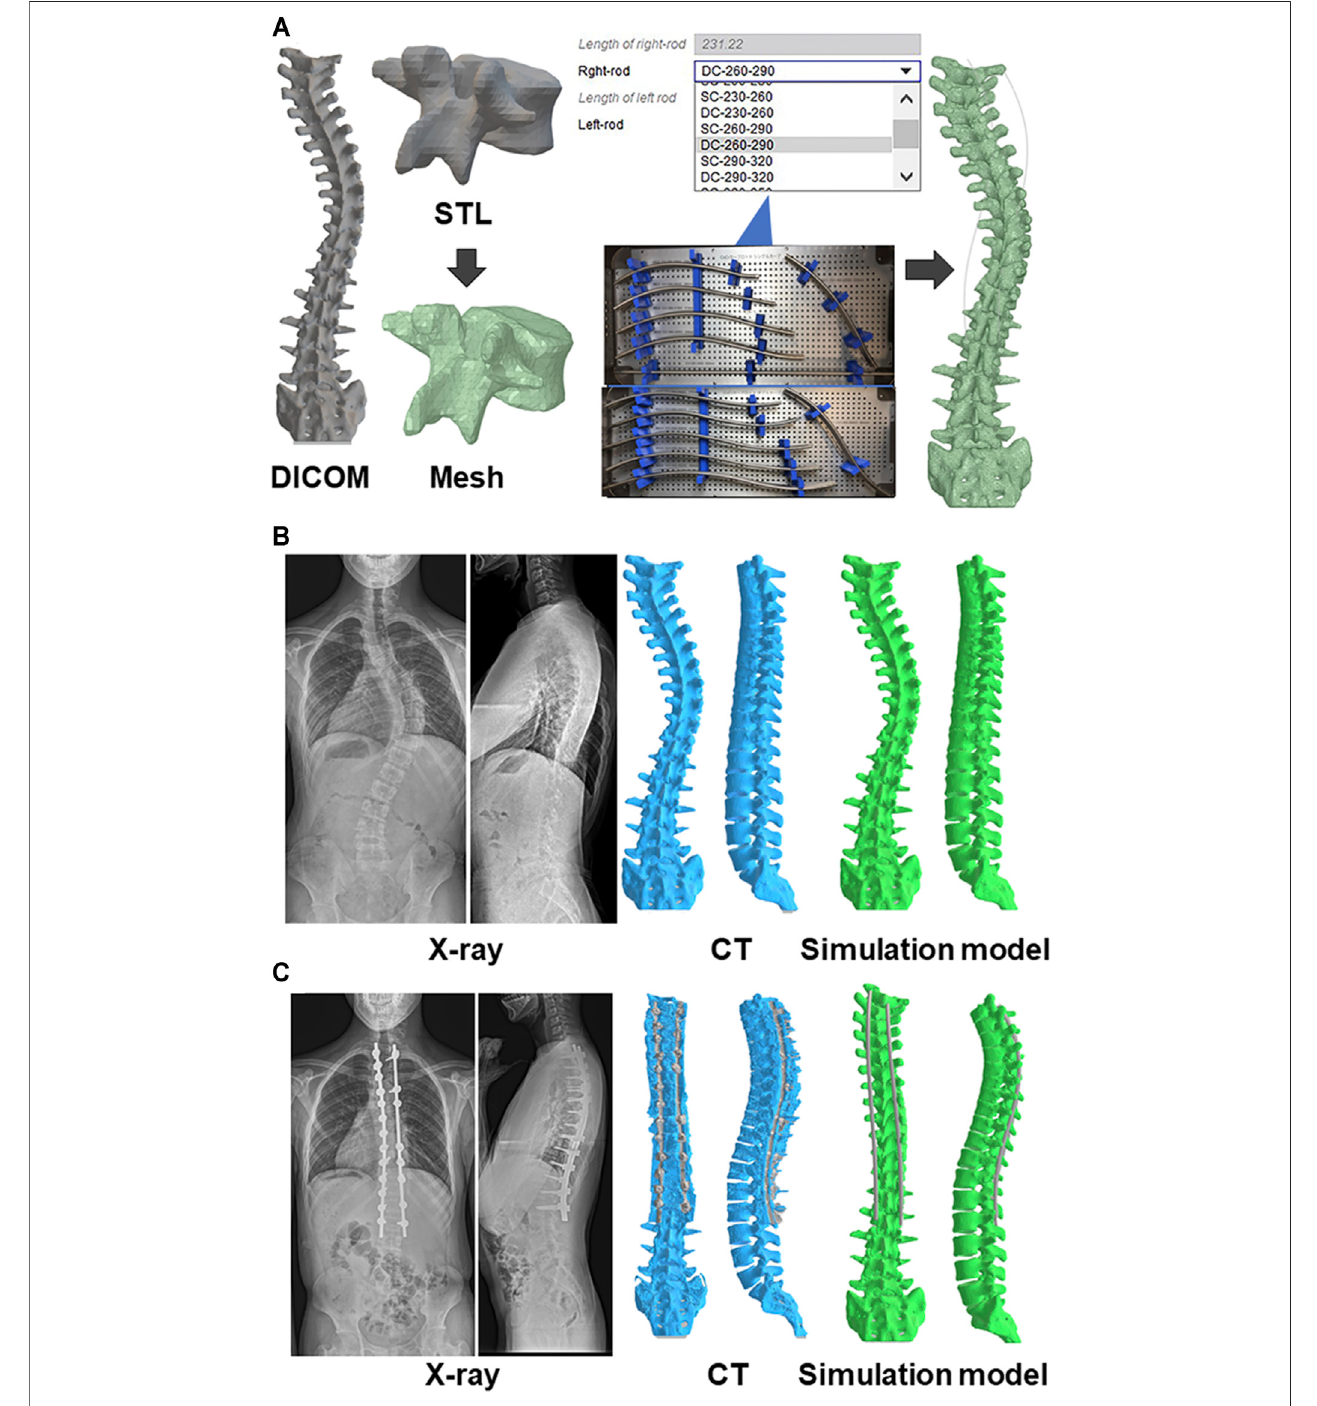
FIGURE 1 | Biomechanical model of the spine (A) A custom spinal fi nite element model was constructed based on the preoperative computed tomography (CT) data.ThecollectedrawdataintheDigitalImagingandCommunicationsinMedicine(DICOM)formatwereimportedinastandardtrianglelanguage(STL).Subsequently, the STL data were converted to a solid structure, which were built of 10-node tetrahedral element meshes. Eleven types of beam element rods were selected based on the deformity types and its lengths, and positioned for the screws. Representative pre (B) - and post (C) operative images of radiograph, CT, and simulation model.